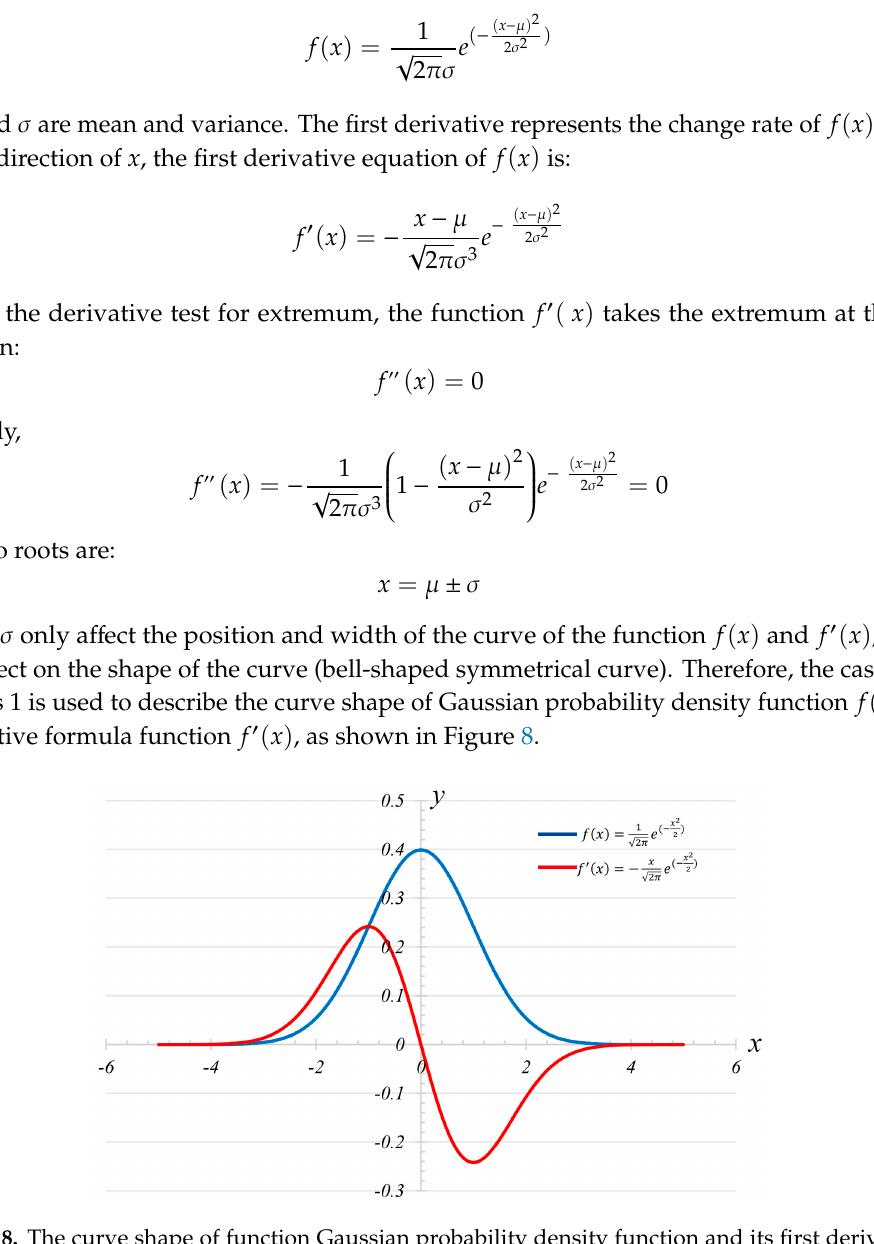
Figure 8. The curve shape of function Gaussian probability density function and its first derivative formula function.